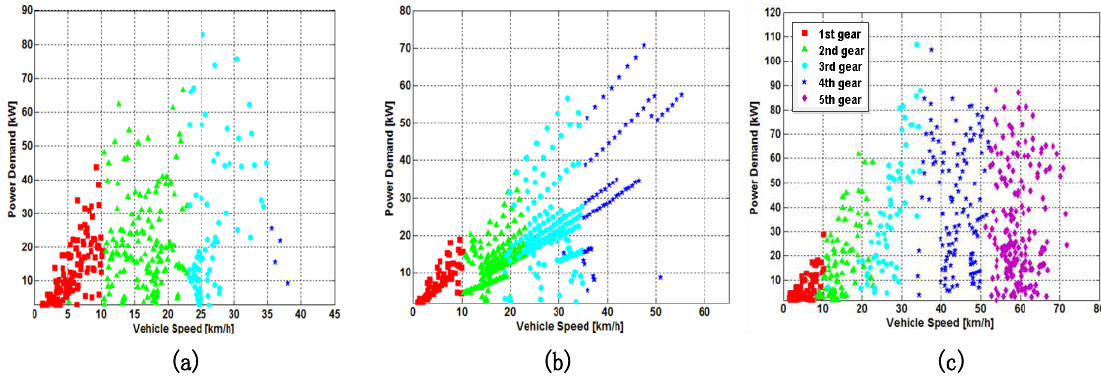
Figure 8. The distribution of AMT gear-shifting loci in three driving cycle conditions. ( a ) Manhattan; ( b ) China typical; ( c ) WVUSUB.